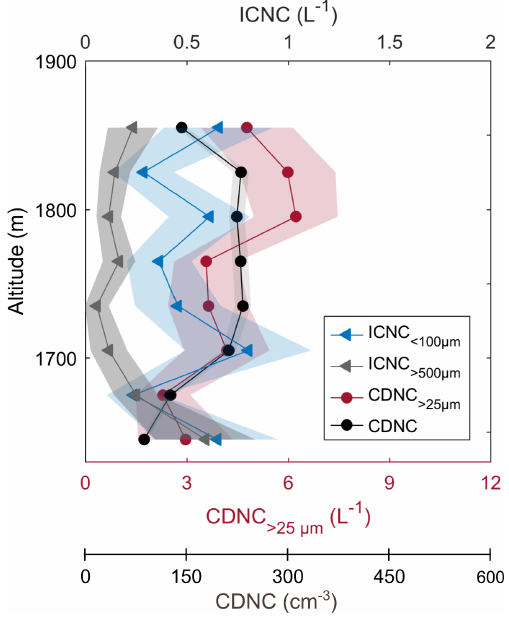
Figure 15. Mean vertical profile of the liquid and ice proper- ties measured in the low-level feeder cloud between 16:45 and 17:45UTC with the HoloBalloon platform. The shaded areas in- dicate the uncertainty of the